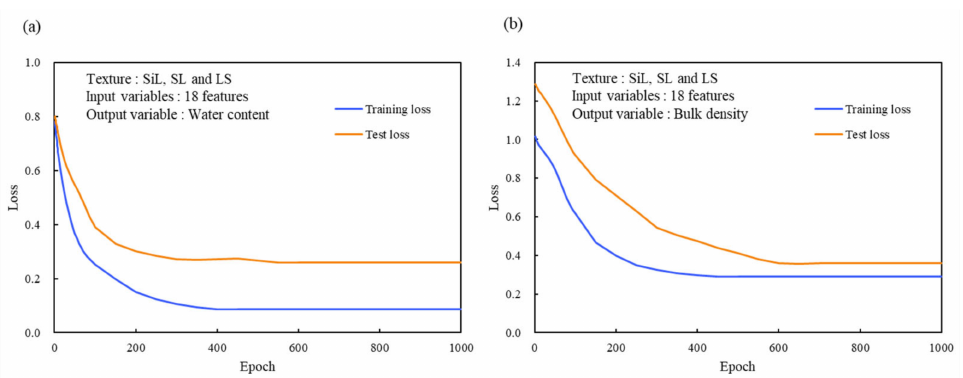
Figure 5. Loss curve of deep neural network regression model: ( a ) for soil water content prediction; ( b ) for bulk density